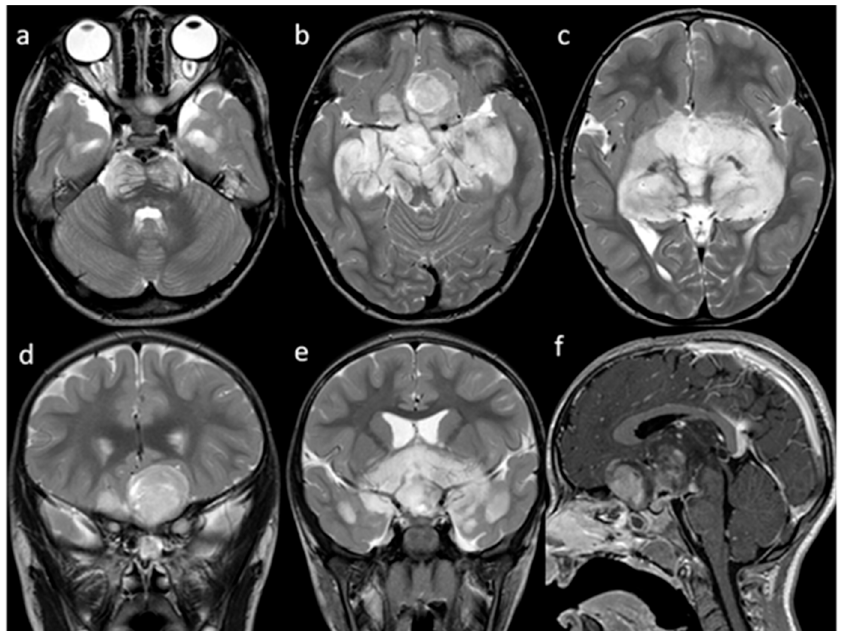
Figure 1. MRI. T2w axial ( a – c ) and coronal ( d , e ) images show a large, heterogeneously hyper-intense, optic-chiasmatic lobulated mass with massive involvement of the optic nerves and tracts, optic radiations, hypothalamus, temporal lobes, and brainstem. The mass compresses the frontal lobes and extends into the third ventricle, resulting in moderate enlargement of the lateral ventricles. Sagittal Gd T1w ( f ) image shows inhomogeneous contrast-enhancement of the suprasellar mass. The patient underwent a biopsy (stereotactic robot-assisted needle biopsy by a right transfrontal route of the lesion) that allowed the diagnosis of ganglioglioma grade 1